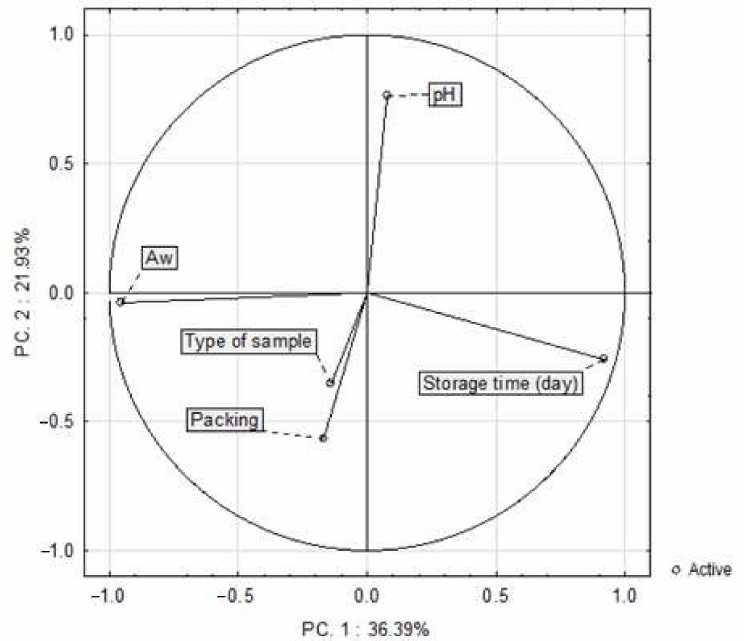
Figure 3. The principal component and load analysis in the analysis of water activity (A w ) and pH depending on the type of sample, packing and storage time ( n =